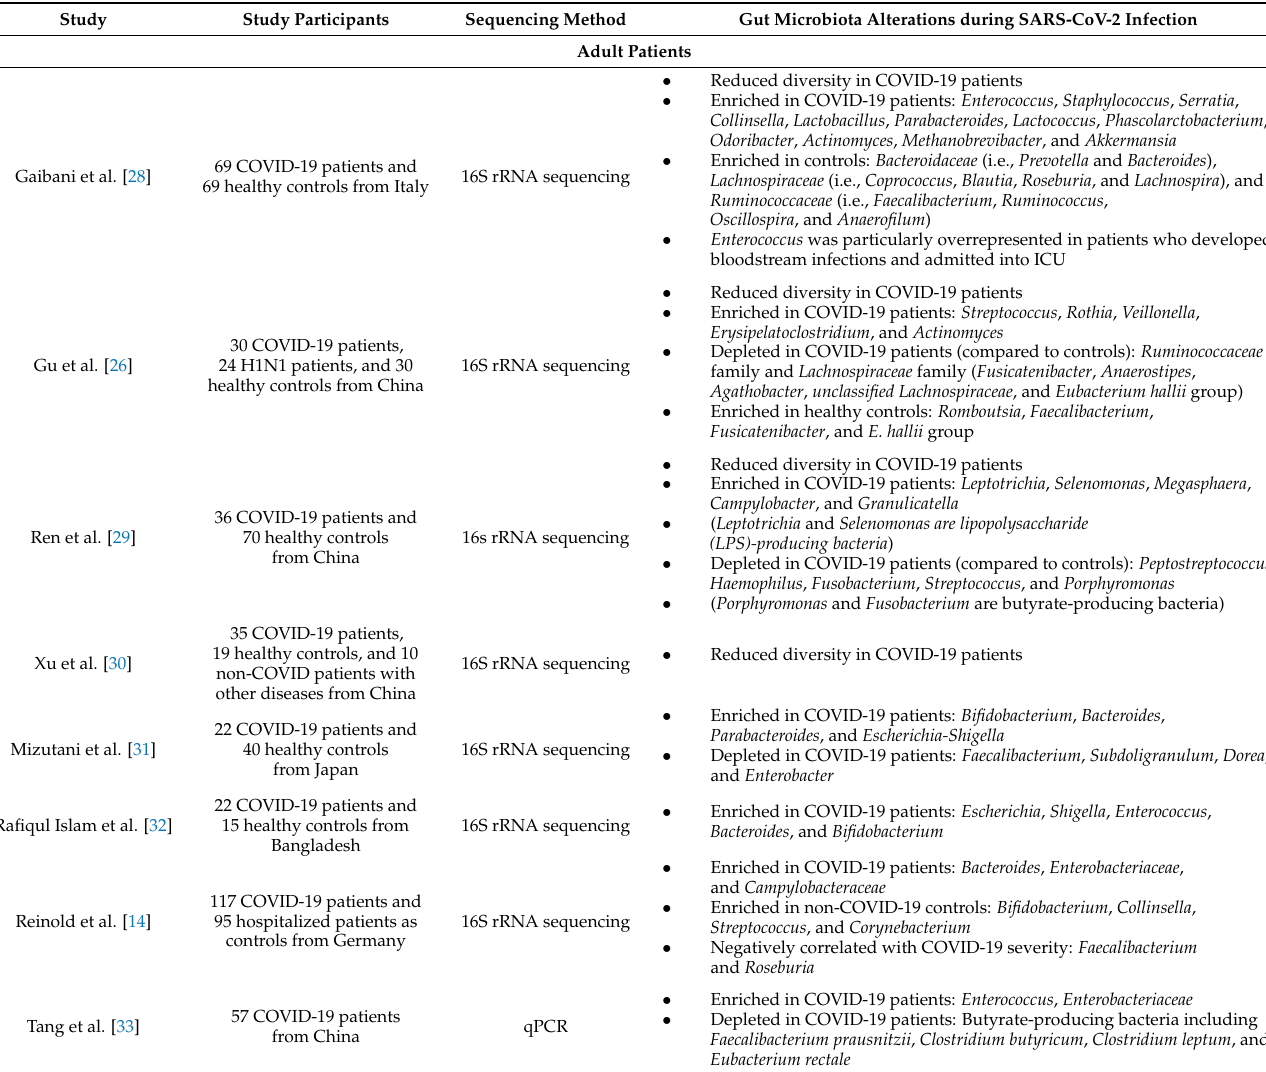
Table 1. Summary of observational studies on gut microbiota alterations in COVID-19